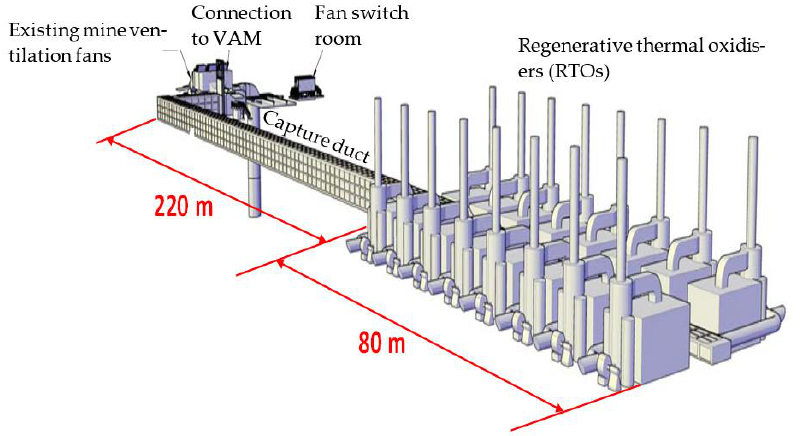
Figure 1. Perspective view of a typical RTO-based VAM abatement plant (not to scale).